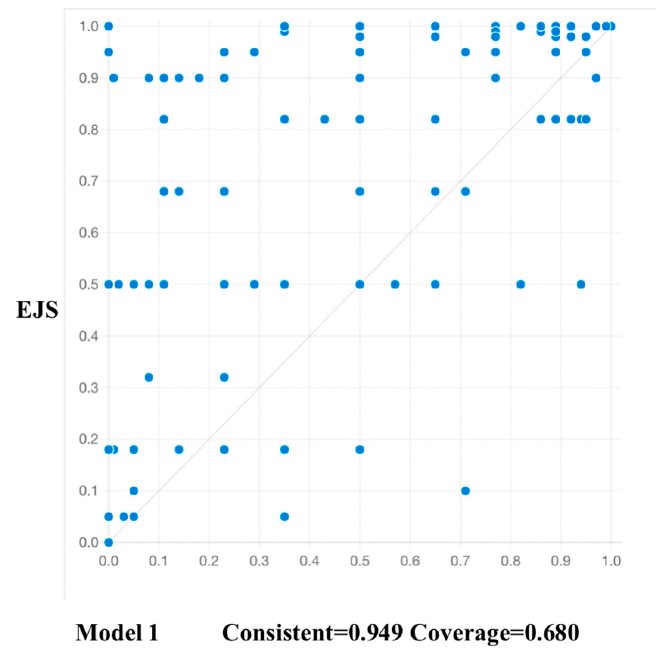
Figure 2. Test of Model 1 for EJS in sub-sample 1 using data from sub-sample 2.